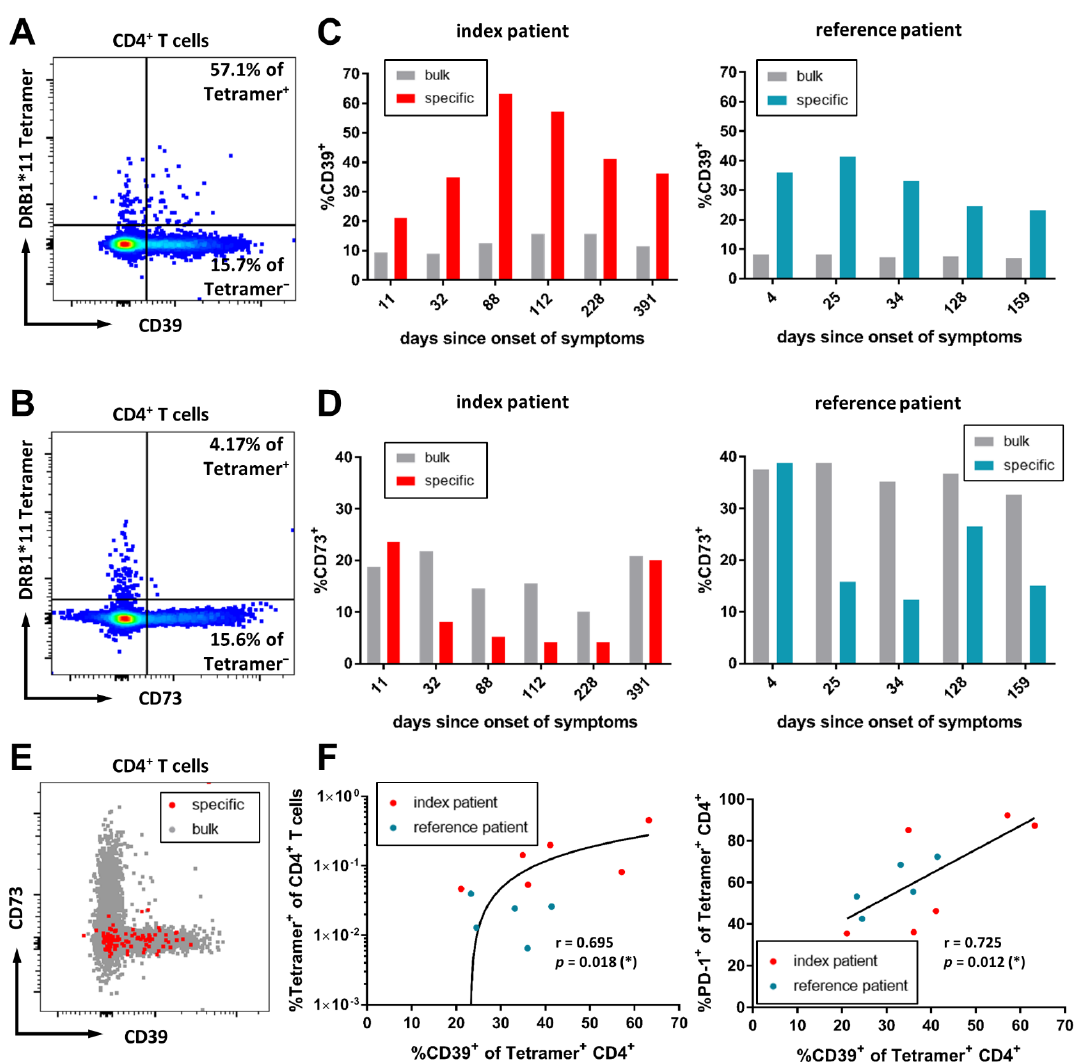
Figure 3. Ectonucleotidases CD39 and CD73 on SARS-CoV-2-specific CD4 + T-cells. Exemplary flow cytometry plots of the index patient (day 112) for expression of CD39 ( A ) and CD73 ( B ) on bulk and virus-specific CD4 + T-cells. Shown are living CD3 + CD4 + T-cells. ( C ) Longitudinal assessment of CD39 expression on bulk and virus-specific CD4 + T-cells of the index patient (left) and the reference patient (right). ( D ) Longitudinal assessment of CD73 expression on bulk and virus-specific CD4 + T-cells of the index patient (left) and the reference patient (right). ( E ) Representative flow cytometry plot of the reference patient, with backgating of the virus-specific CD4 + T-cells illustrating the CD39/CD37 expression pattern. ( F ) Correlation of CD39 + virus-specific T-cells with overall Tetramer + CD4 + T-cells (r = 0.695; p = 0.018) and PD-1 expression frequency (r = 0.725; p = 0.012). In correlation analyses, each dot represents an individual time point, and values are given as Pearsons’s r. Results were considered statistically significant if p < 0.05. Levels of significance are translated to asterisks as follows: * p < 0.05; ** p <